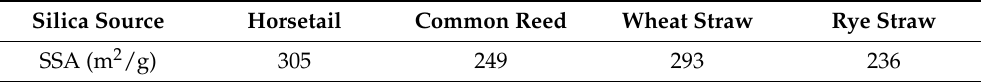
Table 2. Specific surface area (SSA) of silica powders prepared from different types of waste biomass. SSA was determined using the BET method on the basis of low-temperature adsorption isotherms of